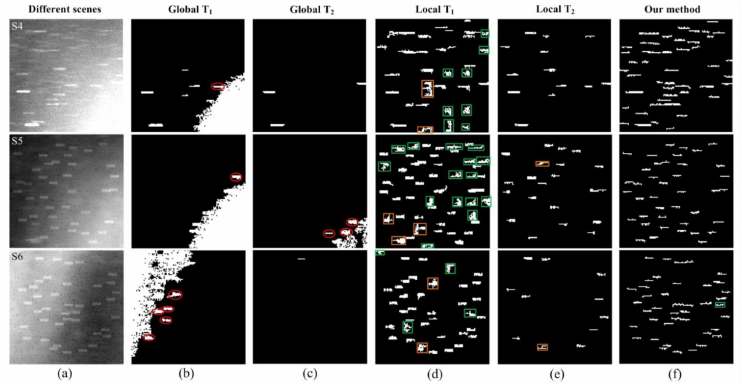
Figure 8. Results of star image segmentation (green squares are false alarms, orange squares are objects that are not clearly identified, and red ellipses are distinguishable objects). ( a ) S4 is an original image, and the lower right part is seriously affected; S5 has forty simulation streaks, and its background comes from S4; S6 is a simulation image with forty streaks, and the upper left part is affected. ( b ) Global T 1 = µ + σ . ( c ) Global T 2 = µ + 2 σ . ( d ) Local T 1 = µ + σ . ( e ) Local T 2 = µ + 2 σ . ( f ) Our proposed